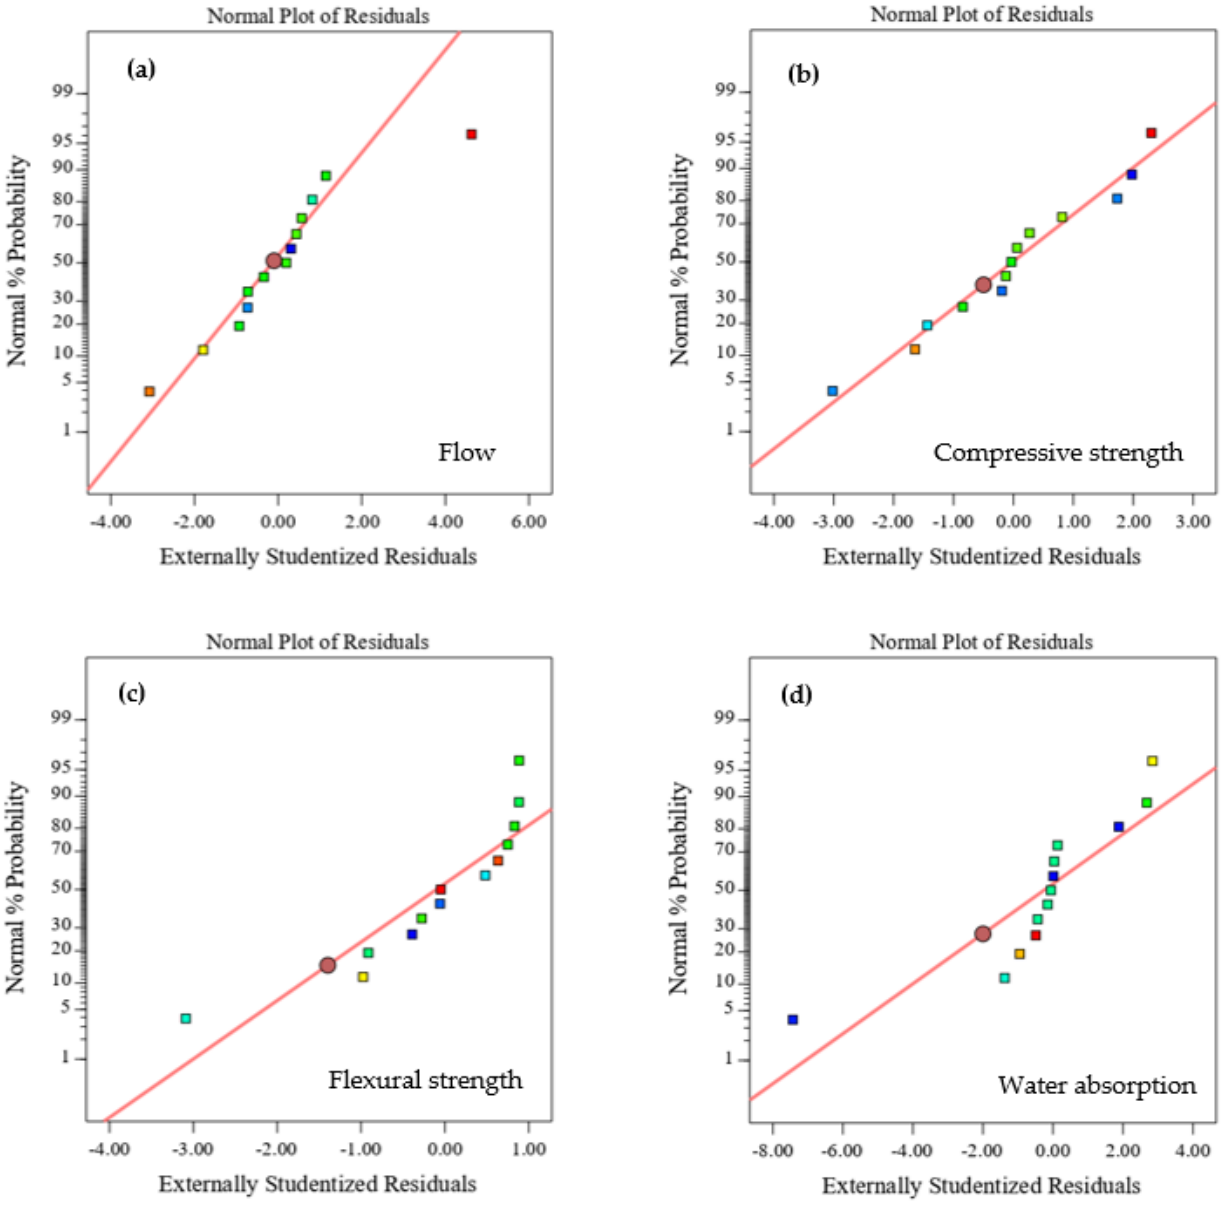
Figure 11. Normal probability plots of ( a ) flow, ( b ) compressive strength, ( c ) flexural strength, and ( d ) water absorption.